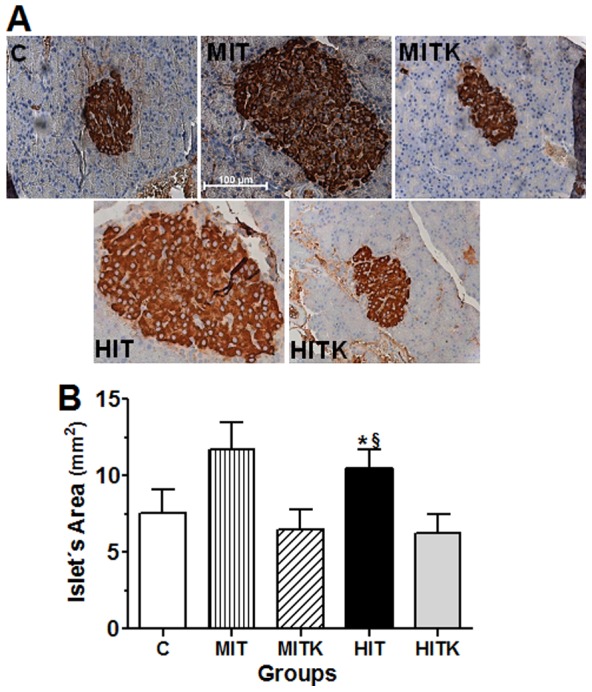
Pancreatic immunohistochemistry, effects of an 8-week treadmill exercise regimen in studied rats.(A) Insulin distribution and (B) pancreatic islet size. Light micrographs reveal the staining patterns of the pancreatic islets; the pancreatic islet areas (mm2) were evaluated in 209 islets. C, control sedentary group; CK sedentary rats that received K252a as in MITK and HITK groups; MIT, medium-intensity training rats; MITK, as MIT with a TrkB inhibitor (K252a) injection; HIT, high-intensity training rats; HITK, as HIT with a TrkB inhibitor injection; data are shown as means ± S.E. *p<0.05 vs. C; §
p<0.05 vs. HITK; ANOVA and Tukey' tests.